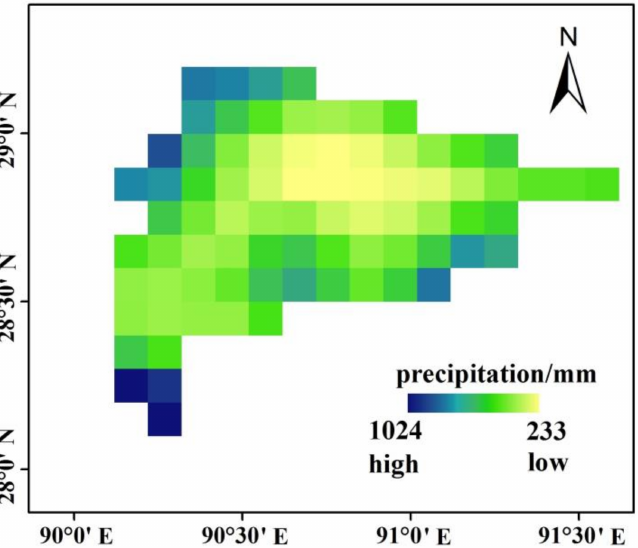
Figure 4. Spatial distribution of High Asia Refined (HAR) data in the Yamzho Yumco Lake basin, Tibetan